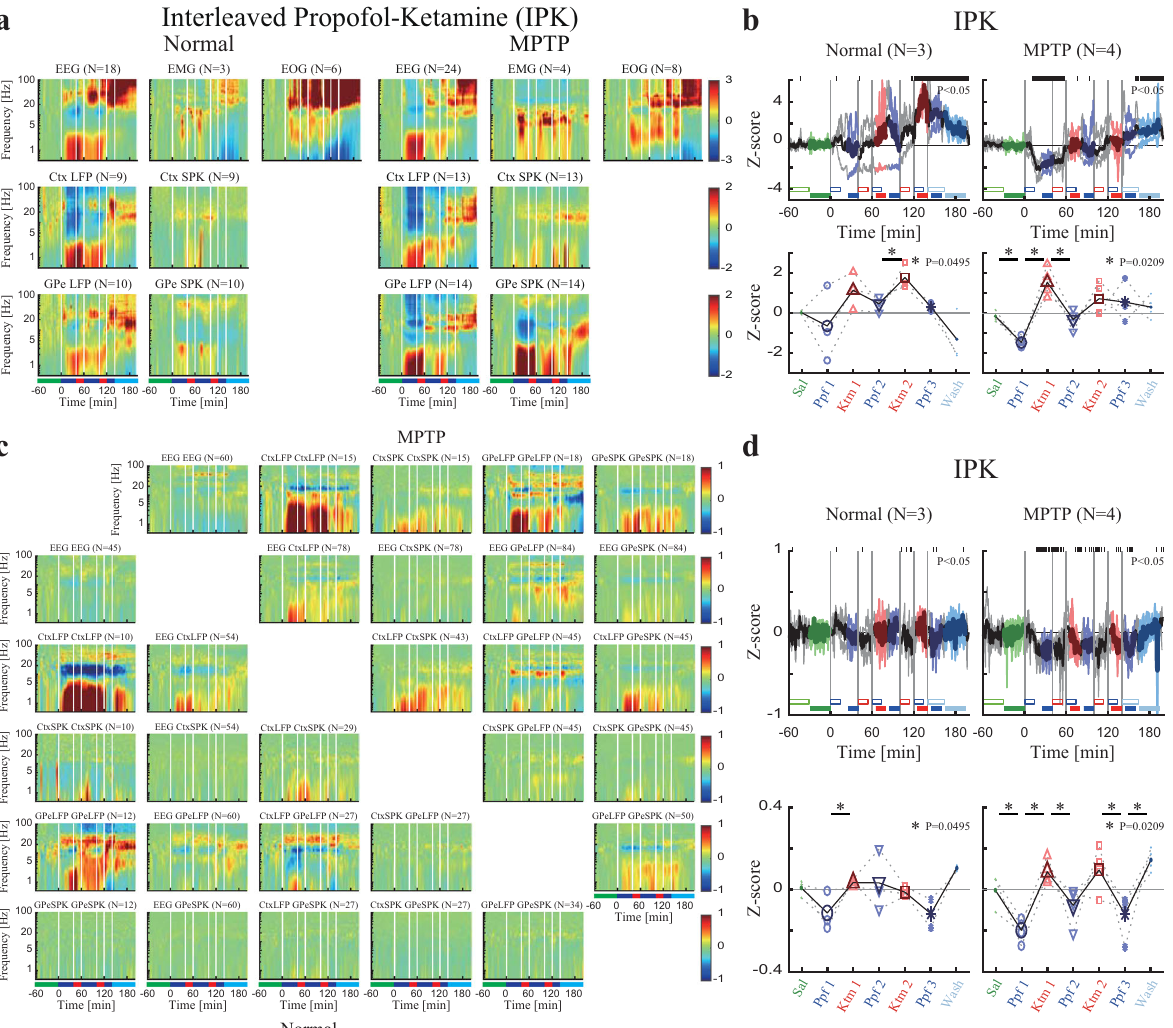
Fig. 5 Interleaved propofol-ketamine (IPK) sedation protocol shows a similar trend of power/synchronization changes as sedation induced by propofol and ketamine alone. a The normalized power spectrograms of EEG/EMG/EOG (1 st row), Ctx LFP/SPK (2 nd row) and GPe LFP/SPK (3 rd row) during IPK before (left) and after (right) MPTP-treatment. Lower bar represents time periods of saline baseline (green), propofol sedation (blue), ketamine sedation (red) and saline washout (cyan). b . Upper. The normalized high/low power difference (averaged through all spectrograms within one session) between high frequency (12 – 40 Hz) and low frequency (0.5 – 4 Hz) mean power before (left) and after (right) MPTP-treatment. Top black horizontal bar represents signi fi cant difference compared to saline ( p < 0.05, Kruskal – Wallis test). Lower. The change from baseline of the normalized high/low power difference during saline (upper, green minus empty green), propofol sedation (upper, blue minus empty blue), ketamine sedation (upper, red minus empty red), saline washout (upper, cyan minus empty cyan) before (left) and after (right) MPTP-treatment. P-value is given, Kruskal – Wallis test. Statistics applied to adjacent sedation stages. c . The normalized coherograms of all pairs of EEG, Ctx LFP/SPK and GPe LFP/SPK during IPK before (lower left) and after (upper right) MPTP- treatment. The 1 st row/column shows coherograms within same signal type (e.g., EEG to EEG), other subplots show coherograms between different signal types. d . Same conventions as b for synchronization difference. Number of sites (a), pairs (c) and sessions (b, d) is given for both monkeys for each subplot. Abbreviations as in Fig. a chamber, head holder and EEG electrodes. The second surgery involved the implantation of a subcutaneous ported central venous catheter. Both surgeries were carried out by board-certi fi ed surgeons (ZI and VK). Anesthesia and perioperative treatment were supervised by an experi- enced anesthesiologist (SF) and the veterinary team of The Hebrew University of Jerusalem.